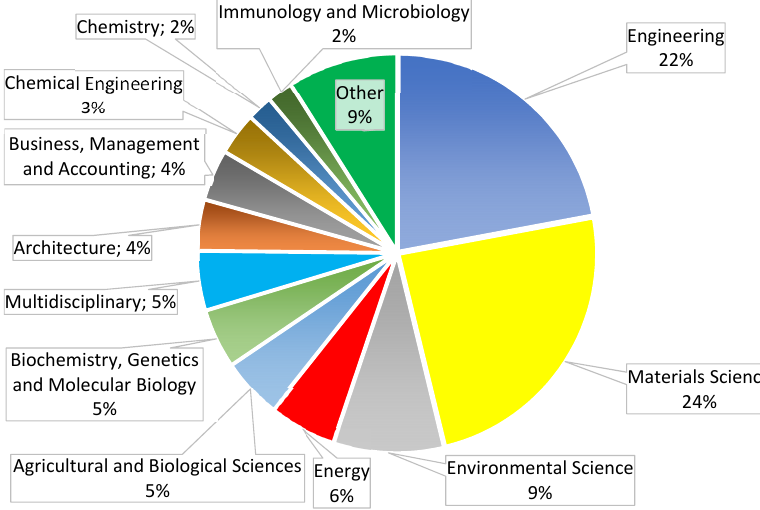
Figure 1. Subject areas of scientific articles on mycelium-based composites.